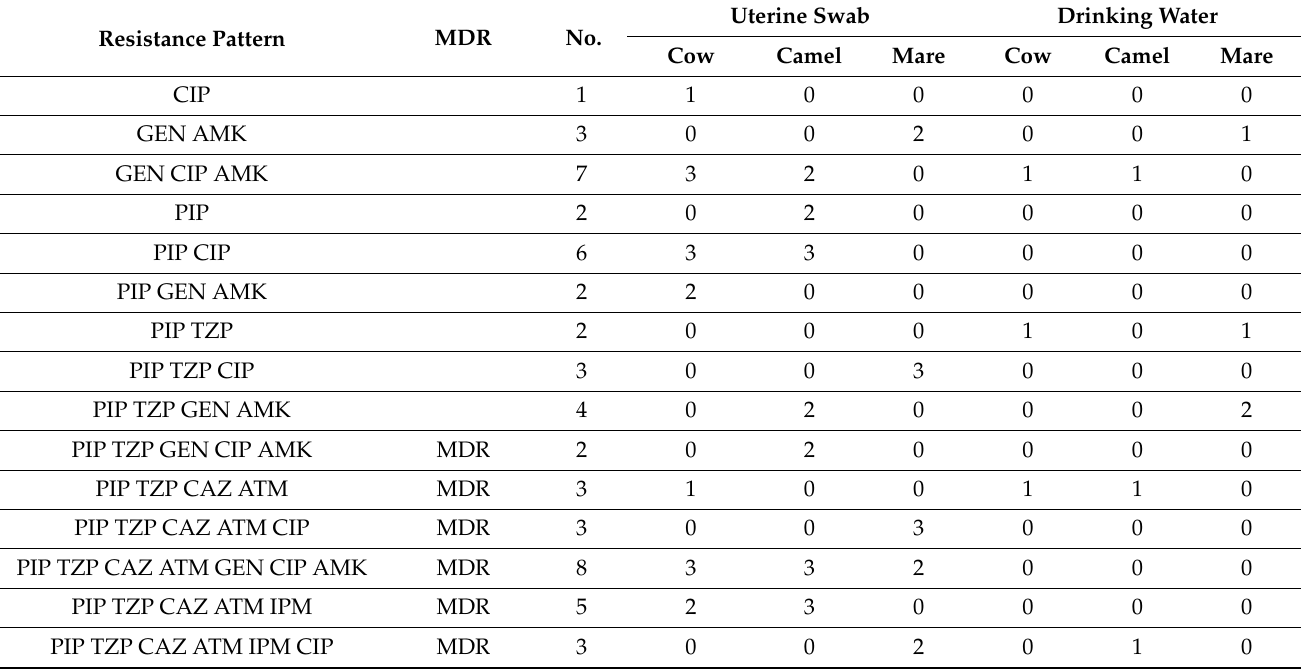
Table 4. Antimicrobial-resistance profile of P. aeruginosa isolates ( n = 54) recovered from cow, camel, mare, and drinking